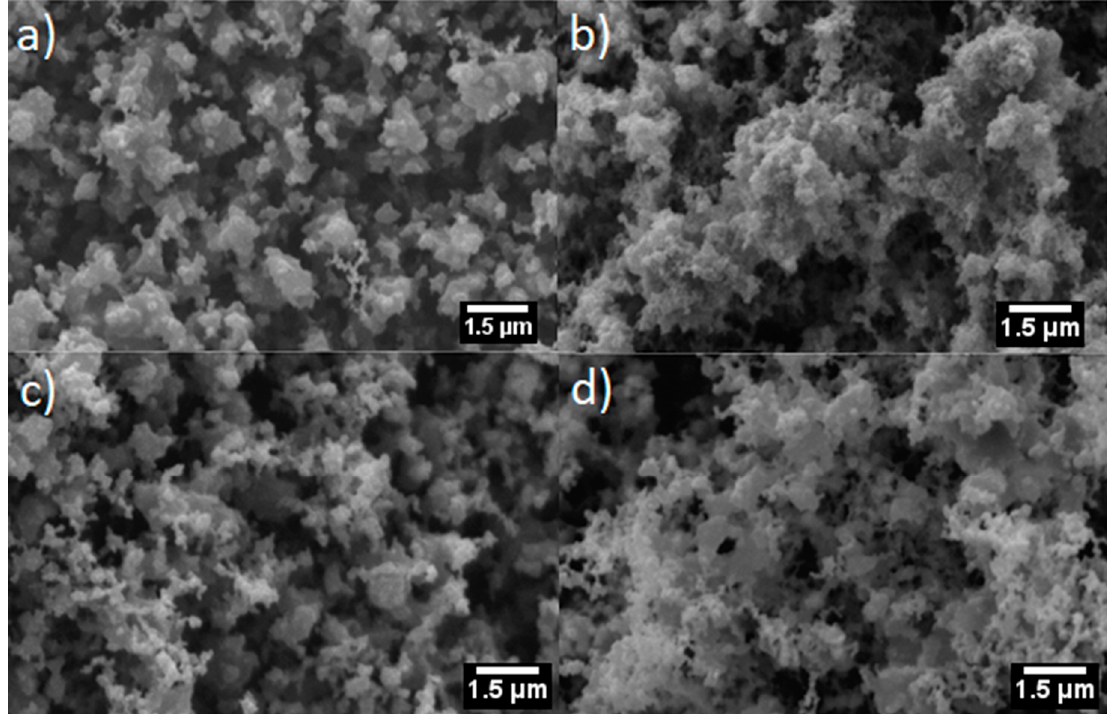
Figure 4. Morphology and structure of the soot coating ( a , c ) in the unaffected areas and ( b , d ) after laser irradiation with p = 171 mW for 350 and 450 s, respectively.